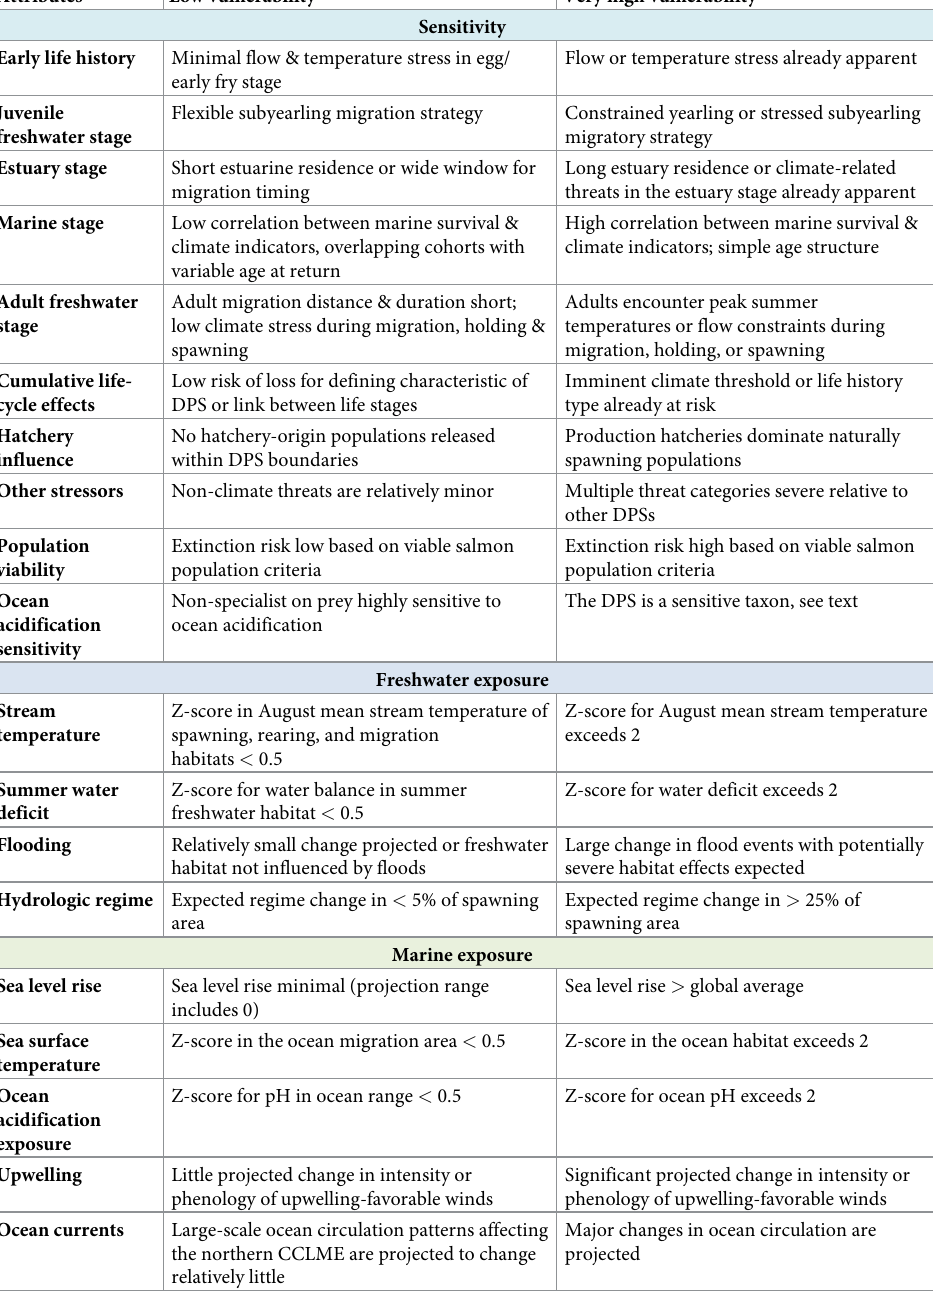
Table 2. Overview of sensitivity and exposure attributes. We developed a rubric for each sensitivity and exposure attribute to standardize scoring across DPSs. We included four freshwater and five marine exposure attributes, each considered within the habitat of the respective DPS and life stage. Full descriptions of scoring criteria are included in the S1 and S2